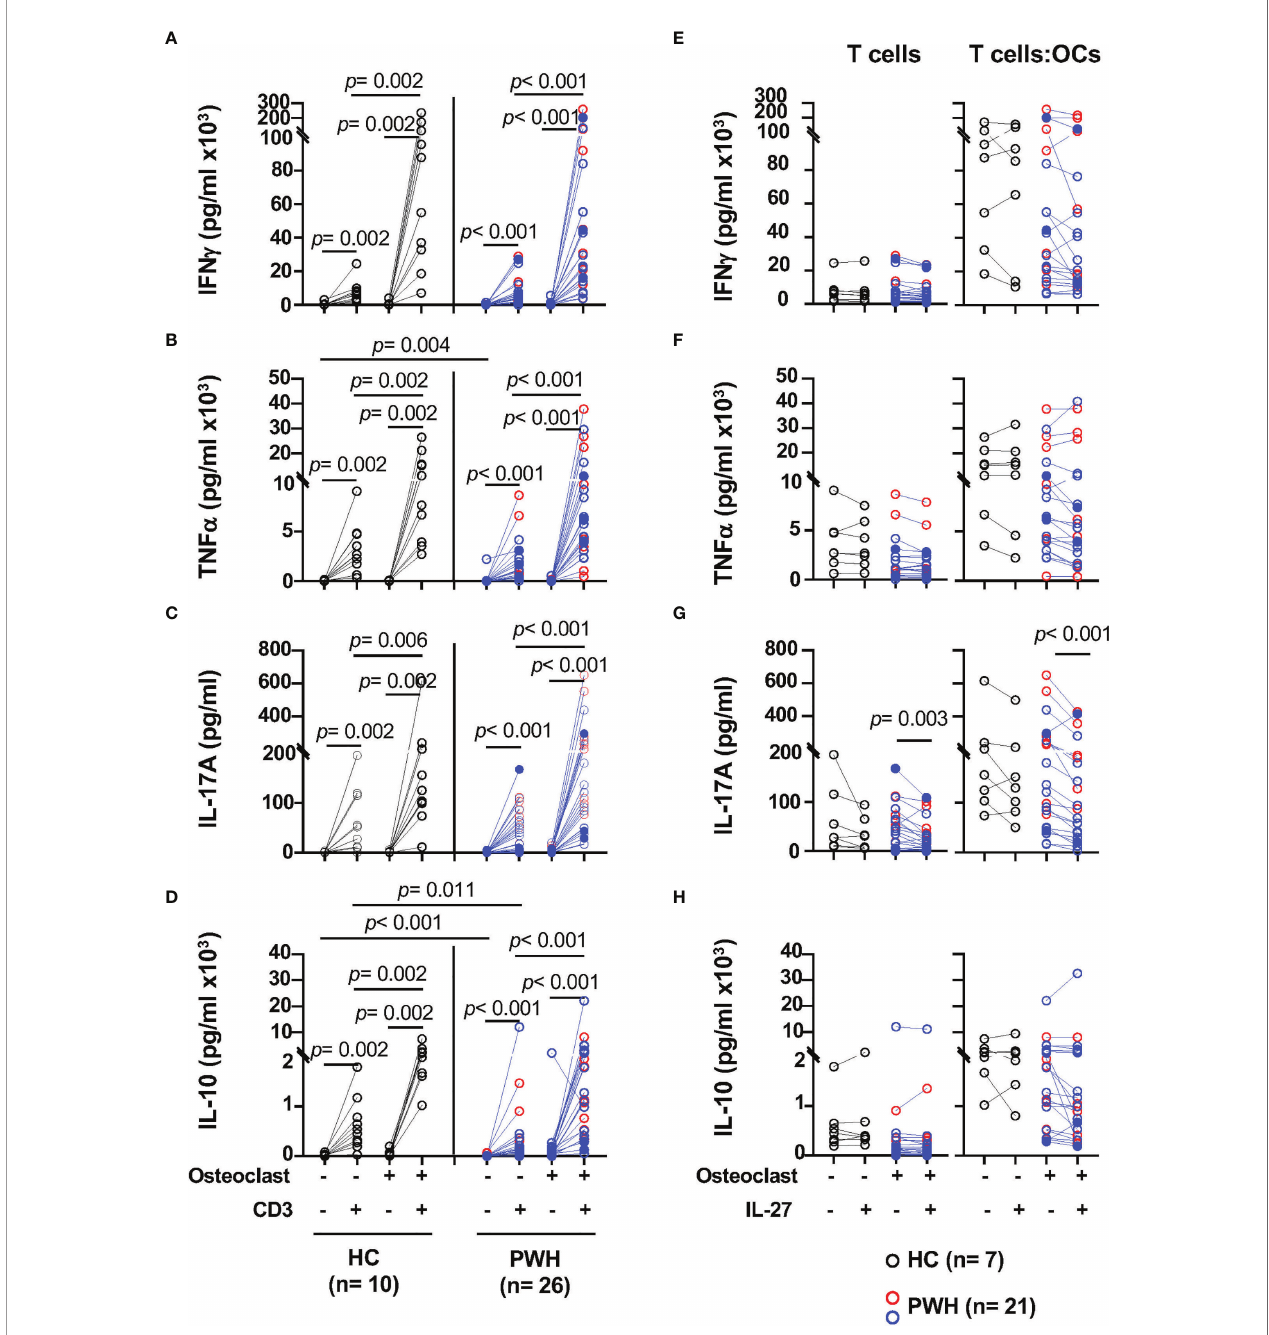
FIGURE 1 | T cells cocultured with osteoclasts (OCs) show enhanced secretion of IFN g , TNF a , IL-17, and IL-10 upon TCR stimulation. Activated T cells from PWH (n = 9, red symbols, HIV + (T) n = 17, opened blue symbols, Table 1 ) and healthy controls (HC, n = 10, black symbols) were cultured alone or in presence of in vitro differentiated autologous osteoclasts at a 5:1 ratio (T cell:OCs). T cells cultured in media were stimulated with CD3/CD28 mAbs overnight and the supernatants were collected to measure cytokines: (A) IFN g , (B) TNF a , (C) IL-17, and (D) IL-10. In the graph, solid blue symbols represent individuals with viral loads >50 copies/ml. T cells cultured alone or in presence of OCs from PWH (n = 7, red symbols, HIV + (T) n = 14, opened blue symbols, Table 1 ) and healthy controls (HC, n = 7, black symbols) were stimulated with CD3/CD28 mAbs in the presence and absence of IL-27 (50 ng/ml) stimulated T cells overnight and the supernatants were collected to measure cytokines: (E) IFN g , (F) TNF a , (G) IL-17, and (H) IL-10. One-way ANOVA was used for comparisons between culture conditions. Post hoc non-parametric Wilcoxon was used for comparisons between culture conditions. Bonferroni test was used to adjust for multiple comparisons. P -value ≤ 0.003 was considered signi fi cant. Post hoc nonparametric unpaired Mann – Whitney test was used for comparisons between the groups adjusted by Bonferroni test. P -value ≤ 0.01 was considered signi fi